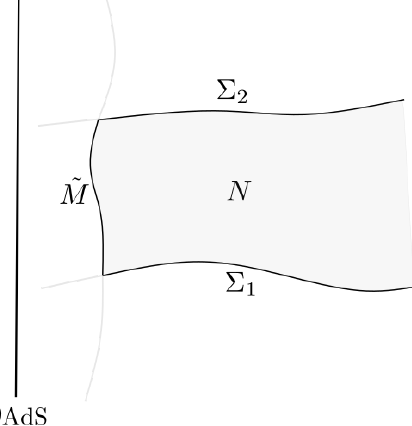
Figure 6: We are looking for holographic proposals for the cost of the path integral on M . ˜ M , Σ , Σ and N are representive of bulk subregions of various codimension 1 2 that can be covariantly defined and on which functions can be evaluated as part of a holographic